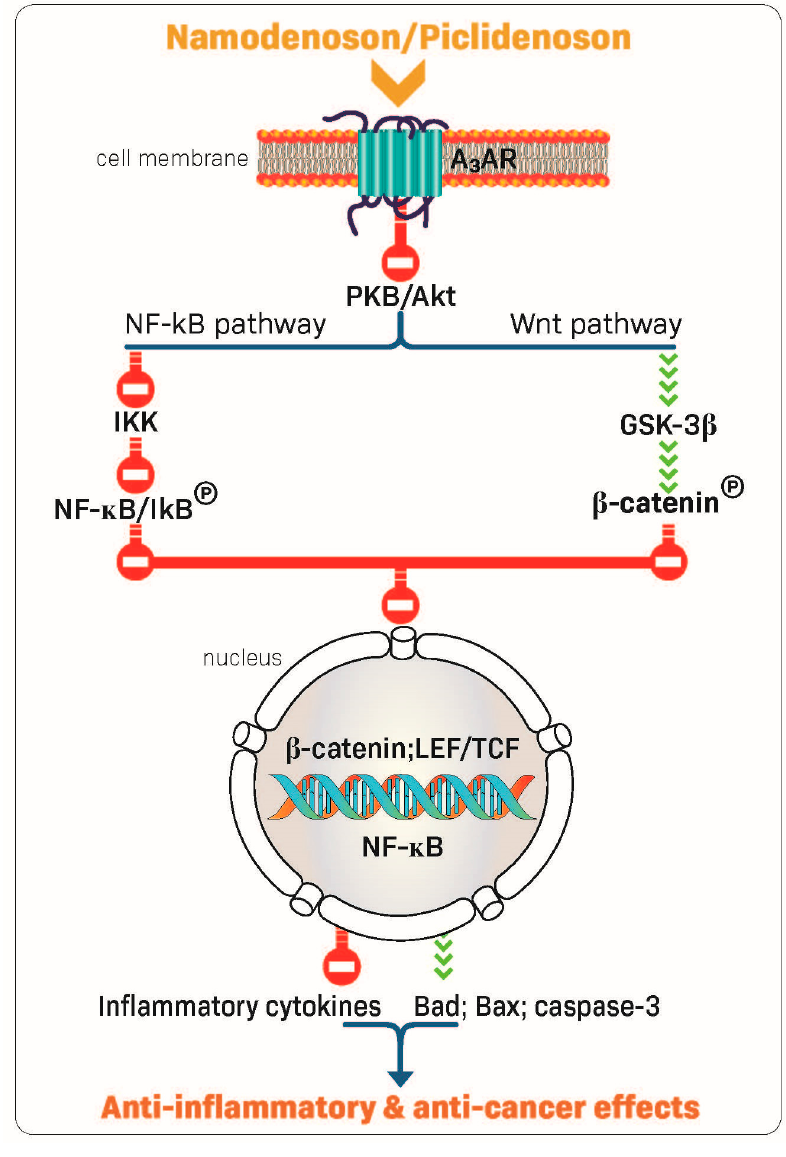
Figure 2. Mechanism of action of piclidenoson and